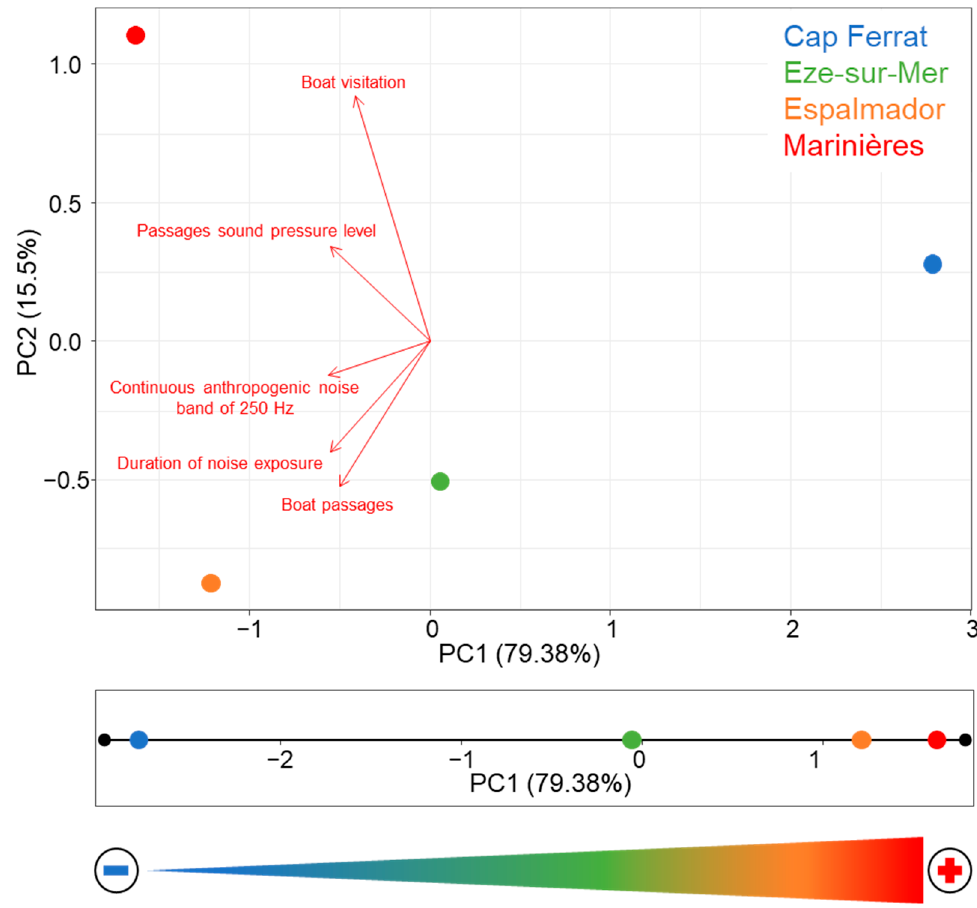
Figure 2. ( Top ): principal component analysis computed on the five variables related to boat MNP estimated in this study. ( Bottom ): projection of the coordinates of the locations on the first PCA axis and inversion of the axis, showing the MNP gradient, from the lowest (Cap Ferrat) to the highest (Marinières) NI value. The arrow represents the gradient, from the lowest ( − ) to the highest (+) MNP produced by boat traffic.